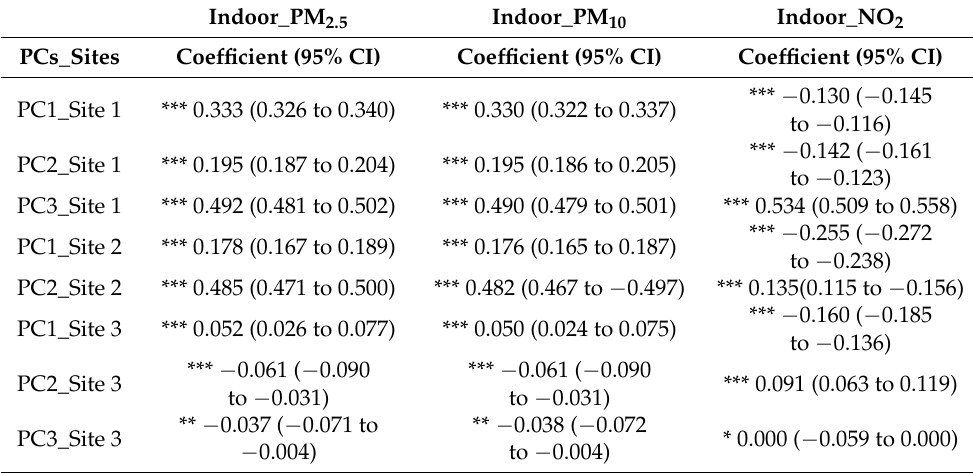
Table 5. Results of the PCA-based linear regression